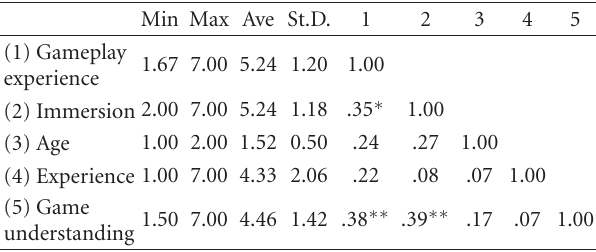
Table 2: Descriptive Statistics. Min Max Ave